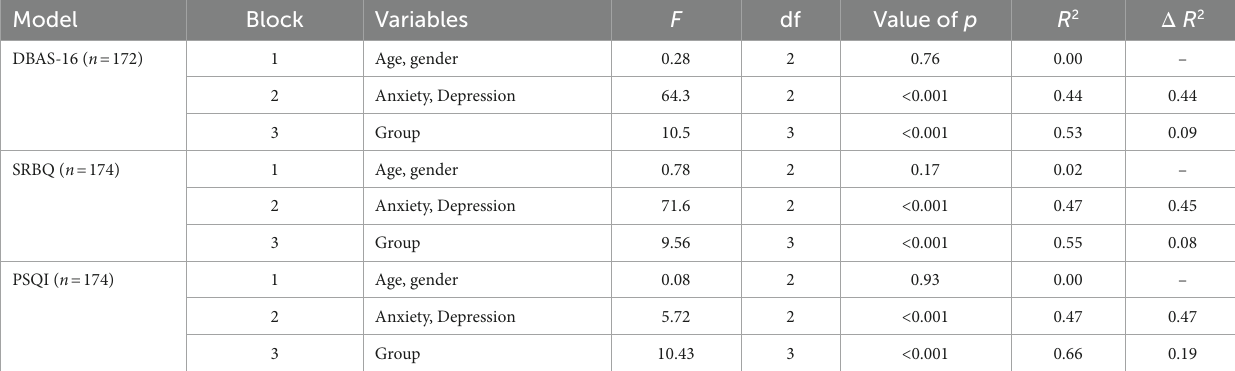
TABLE 3 F -statistics, R -squared, and change in R -squared values derived from hierarchical linear regression models predicting sleep-related cognitions (DBAS-16) / behaviors (SRBQ) / sleep quality (PSQI) from age, gender, anxiety, depression, and group. Model Block